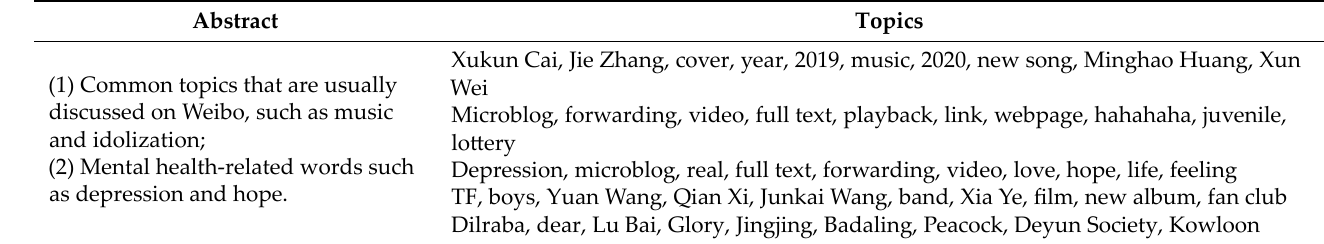
Table 4. Topics and abstract of topics for the depression group.